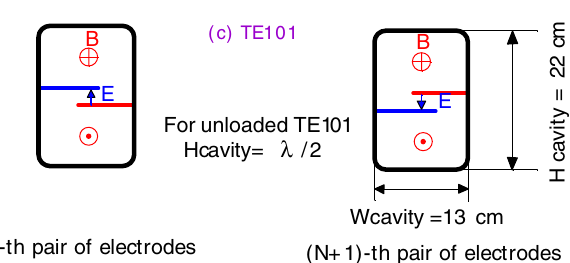
FIG. 2. (Color) (a)–(c) Possible rf deflector